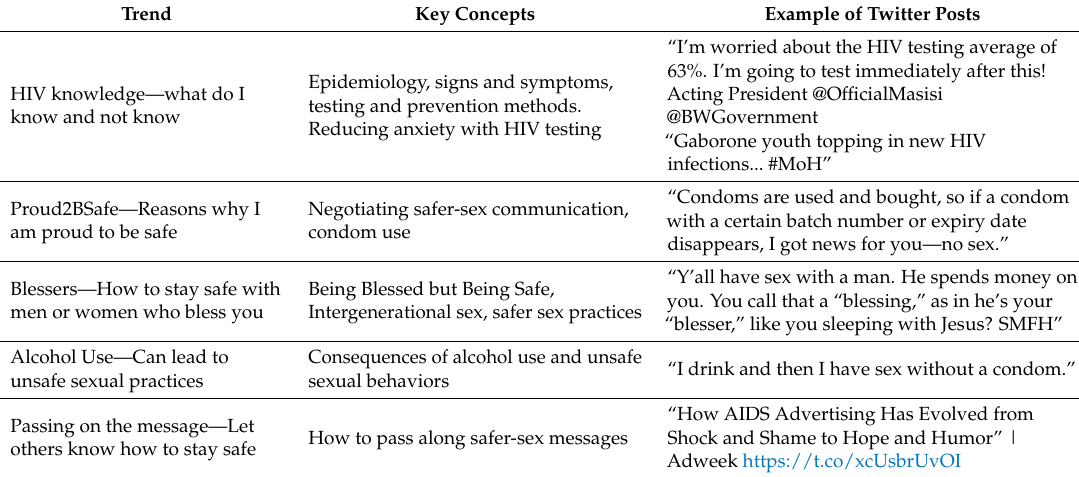
Table 3. Twitter topics related to safe sex